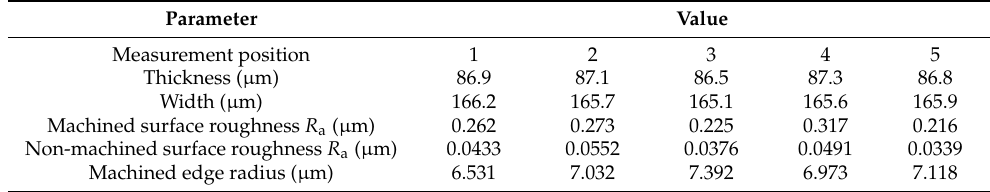
Table 6. Measurement results of machining indicators of the pure aluminum rectangular mandrel.